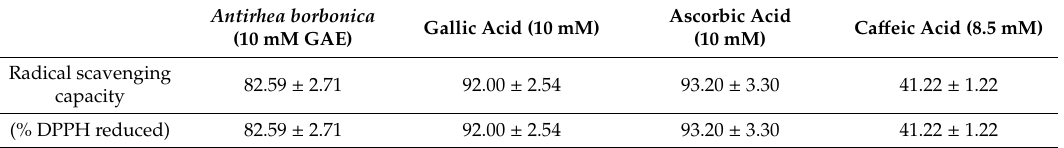
Table 3. 2,2-Diphenyl-1-picrylhydrazyl (DPPH) of Antirhea borbonica plants extract and standard phenolic compounds.